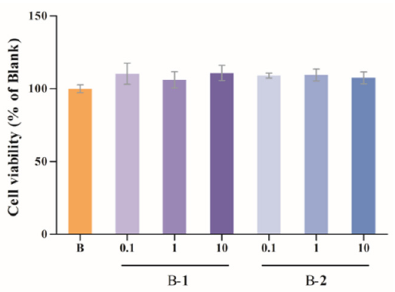
Figure 1. The cell viability of benzaldehydes 1 – 2 in BV-2 cells. Data were expressed as the means ± S.D ( n = 3).